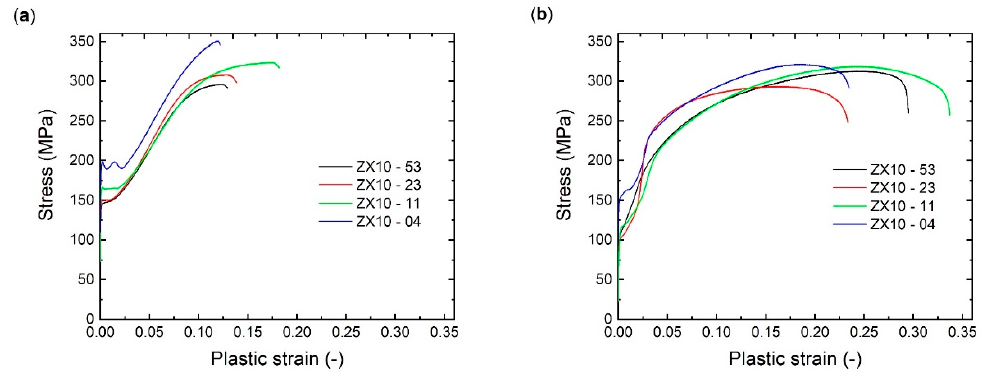
Figure 5. Compressive ( a ) and tensile ( b ) deformation behaviour of the extruded ZX10 alloy after pre- compression up to 3% of plastic strain and subsequent heat treatment (16 h @ 150 °C).